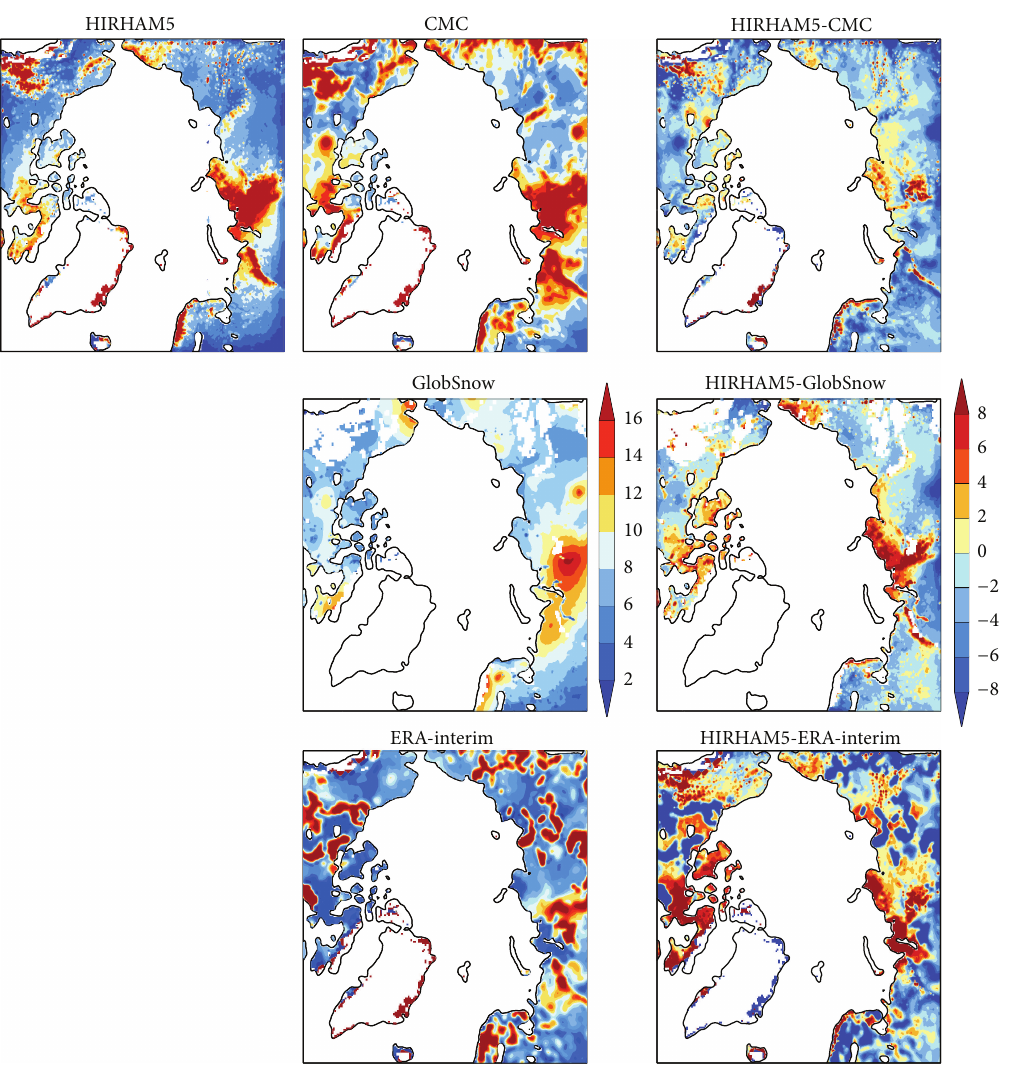
Figure 3: Snow water equivalent (cm) averaged over 2008–2010 for spring derived from HIRHAM5, CMC, GlobSnow, ERA-Interim and their corresponding differences “HIRHAM5 minus CMC”, “HIRHAM5 minus GlobSnow”, “HIRHAM5 minus